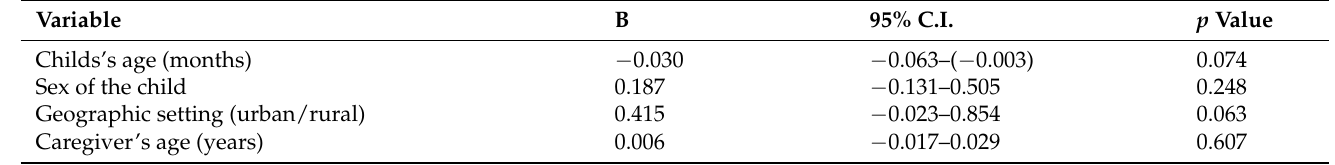
Table 4. Factors affecting nutritional status of children aged 6–23 months in the study